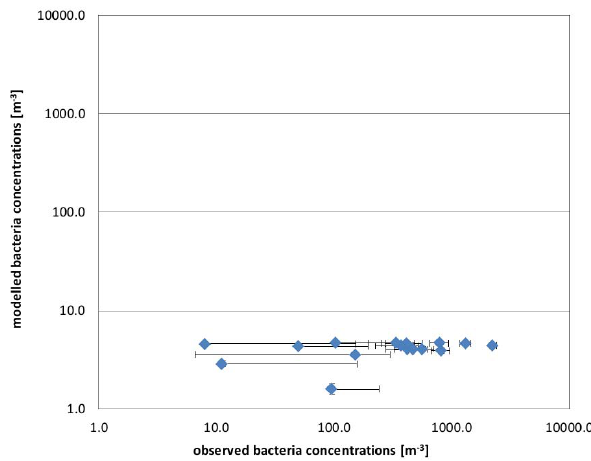
Fig. 5. Simulated bacteria concentrations at ground level, divided by factor 100 in order to account for viable bacteria, compared to observations. Observations are averages over different time periods, and the simulated data were interpolated to the measurement loca- tion. The bars indicate the standard deviation for all measurements at one location. Observations are taken from Bauer et al. (2002), Bovallius et al. (1978a), Bovallius et al. (1978b), Borodulin et al. (2005), Chen et al. (2001), DiGiorgio et al. (1996), Fang et al. (2007), Kelly and Pady (1954), Lindemann et al. (1982), Mouli et al. (2005), Negrin et al. (2007), Pastuszka et al. (2000), Rosas et al. (1994), R¨uden et al. (1978), Schlesinger et al. (2006), Shaffer and Lighthart (1997), Tilley et al. (2001), and Vlodavets and Mats